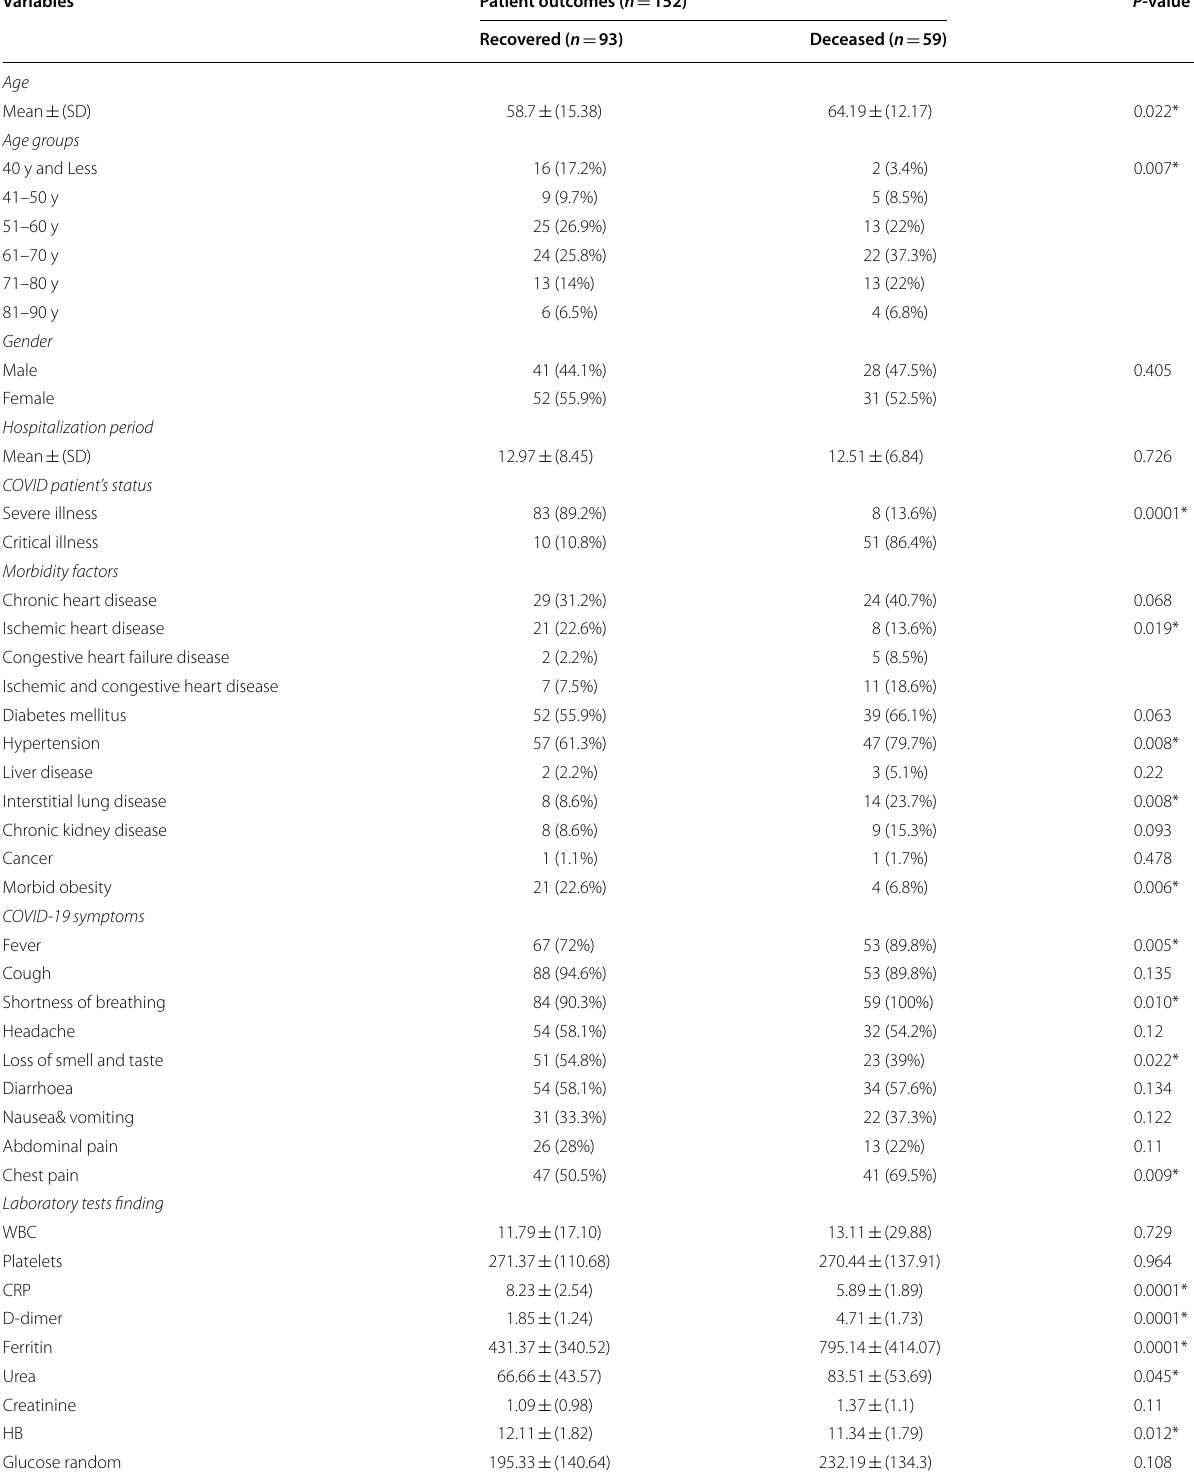
Table 1 Clinical and laboratory data characteristics for COVID19